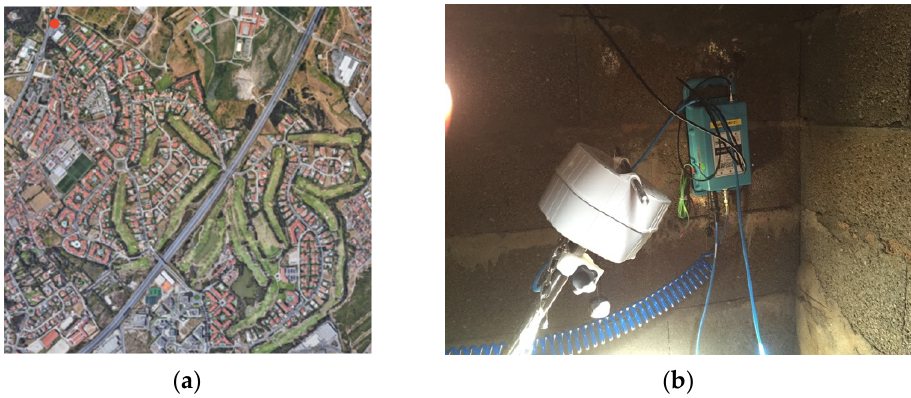
Figure 6. Aerial view of the Beloura DMA ( a ); flowmeter and data-logger ( b ).